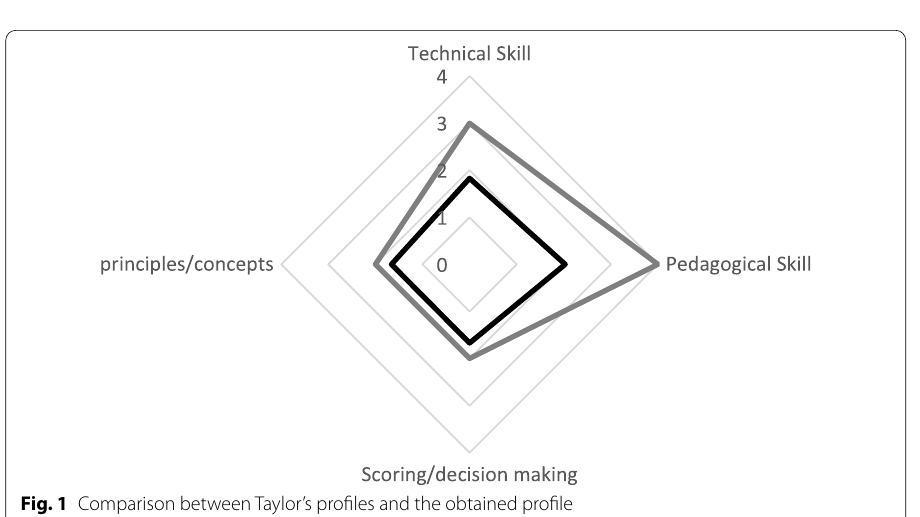
Fig. 1 Comparison between Taylor’s profiles and the obtained